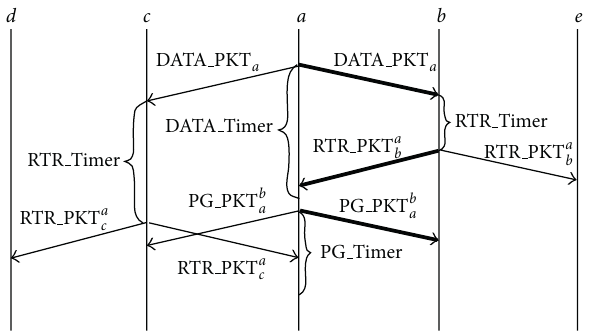
Figure 4: LRWR protocol sequence